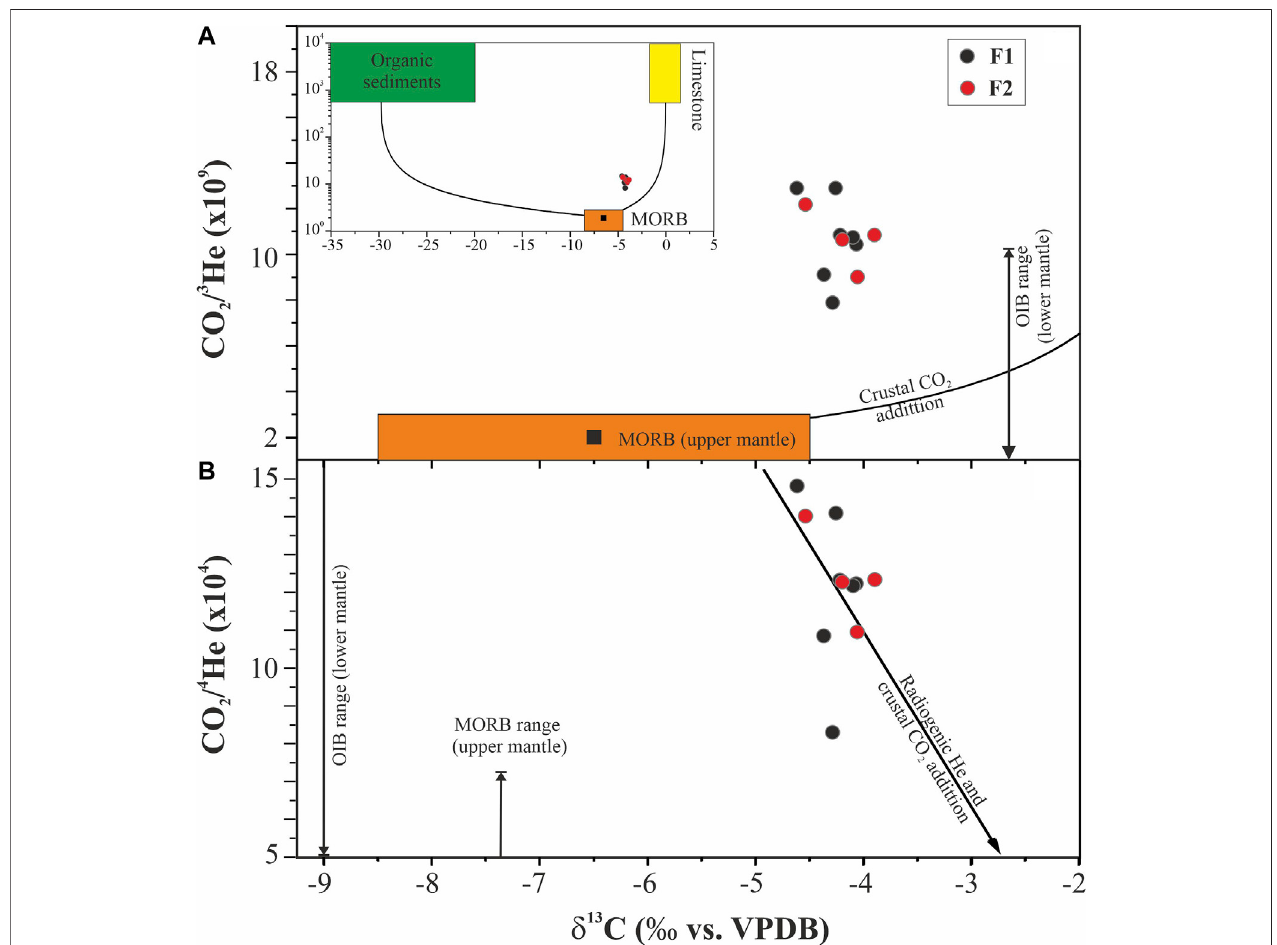
FIGURE 9 | (A) CO 2 / 3 He ratio vs. δ 13 C – CO 2 values for F1 and F2 fumarole samples. MORB, organic sediments and marine limestone end-members are shown. Solidlinesrepresentbinarymixingcurvesformantle-organicsediments,andmantle-marinelimestone.Endmembers:MORB δ 13 C – CO 2 (cid:2)− 6.5 ± 2 ‰ andCO 2 / 3 He (cid:2) 2 × 10 9 ;organic sediments δ 13 C – CO 2 − 30 ± 10 ‰ andCO 2 / 3 He 1 × 10 13 ;marine limestone (includingslabcarbonates): δ 13 C – CO 2 0 ± 2 ‰ and 1 × 10 13 (Marty et al.,1989; Sano and Marty, 1995; Sano and Williams, 1996). (B) CO 2 / 4 He vs. δ 13 C – CO 2 for F1 and F2 fumarole samples [modi fi ed from Caliro et al. (2015)].